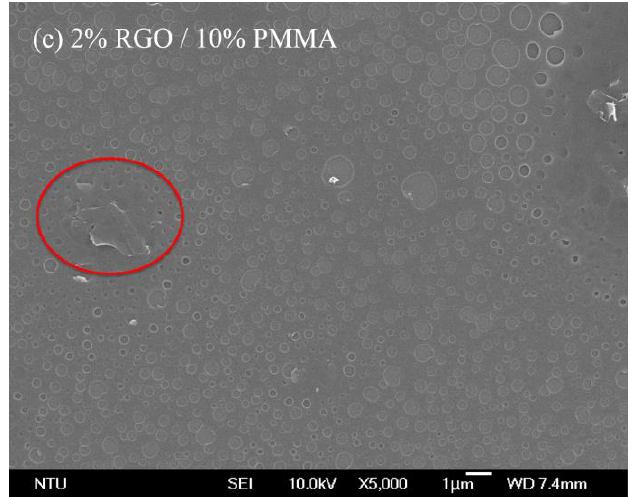
Figure 1. SEM pictures of different RGO/PMMA sensing film compositions: ( a ) 2% RGO, ( b ) 2% RGO/5% PMMA, and ( c ) 2% RGO/10% PMMA composite. The red circles indicate the graphene sheets.